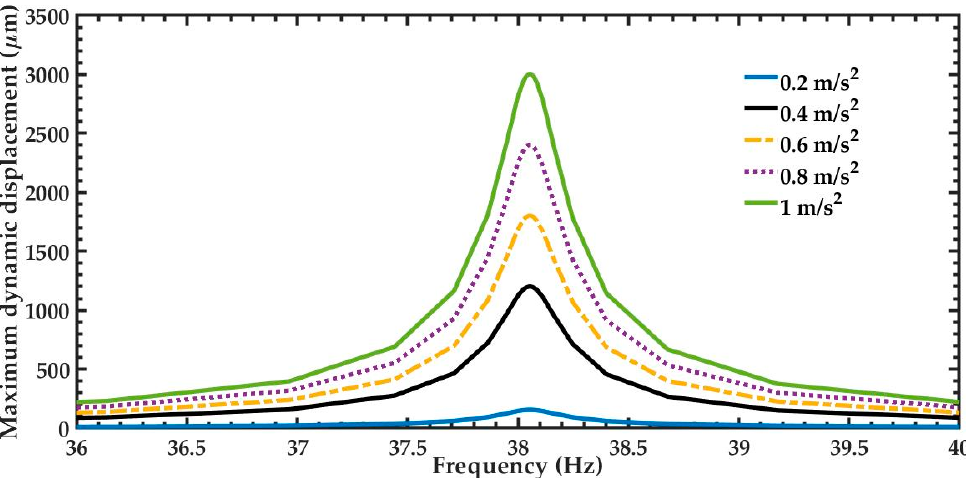
Figure 13. Dynamic displacement of the pVEH microdevice for different acceleration values.